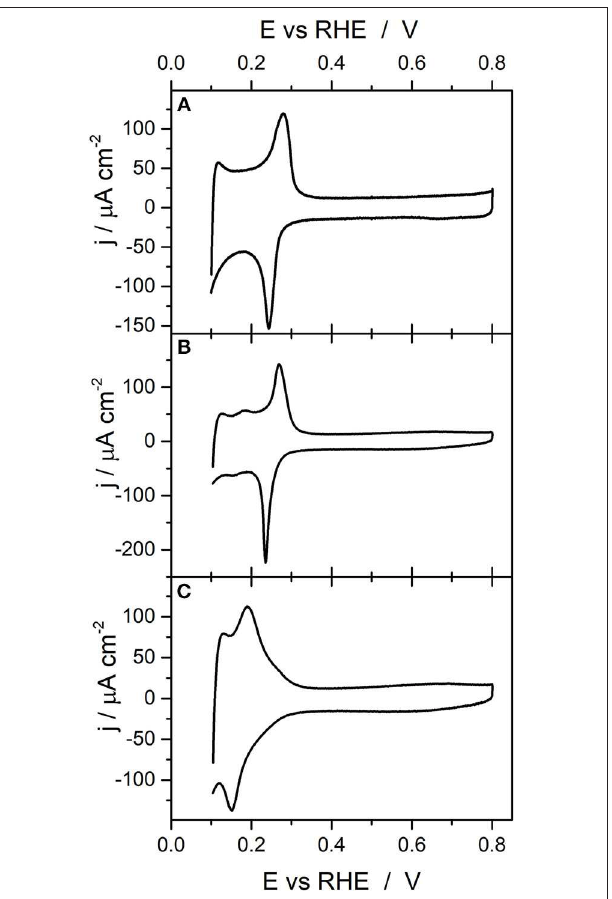
FIGURE 3 | Voltammetric profiles obtained with (A) Pd 20 Cub , (B) Pd 10 Cub , and (C) Pd 3 Sp nanoparticles. Test solution 0.1M H 2 SO 4 , scan rate 50mV s − 1